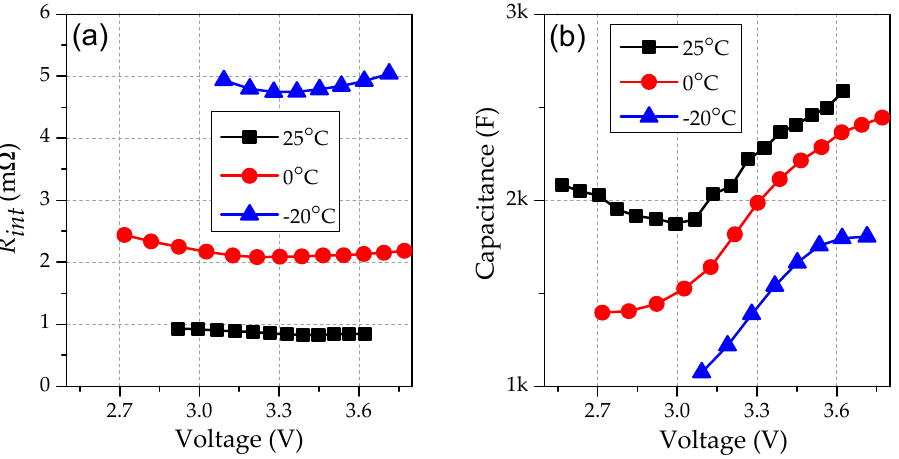
Figure 6. ( a ) Internal resistance and ( b ) capacitance measured at different temperatures (+25 °C, 0 °C, and − 20 °C) as a function of voltage for the Li-ion UC.